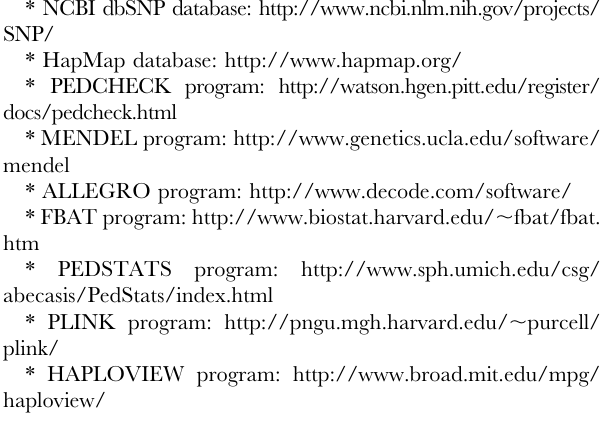
Table S4 Single SNP (1), and haplotype-based (2) association results in HLA-B27 positive case/control sample (261 SpA cases/ 27 healthy controls).